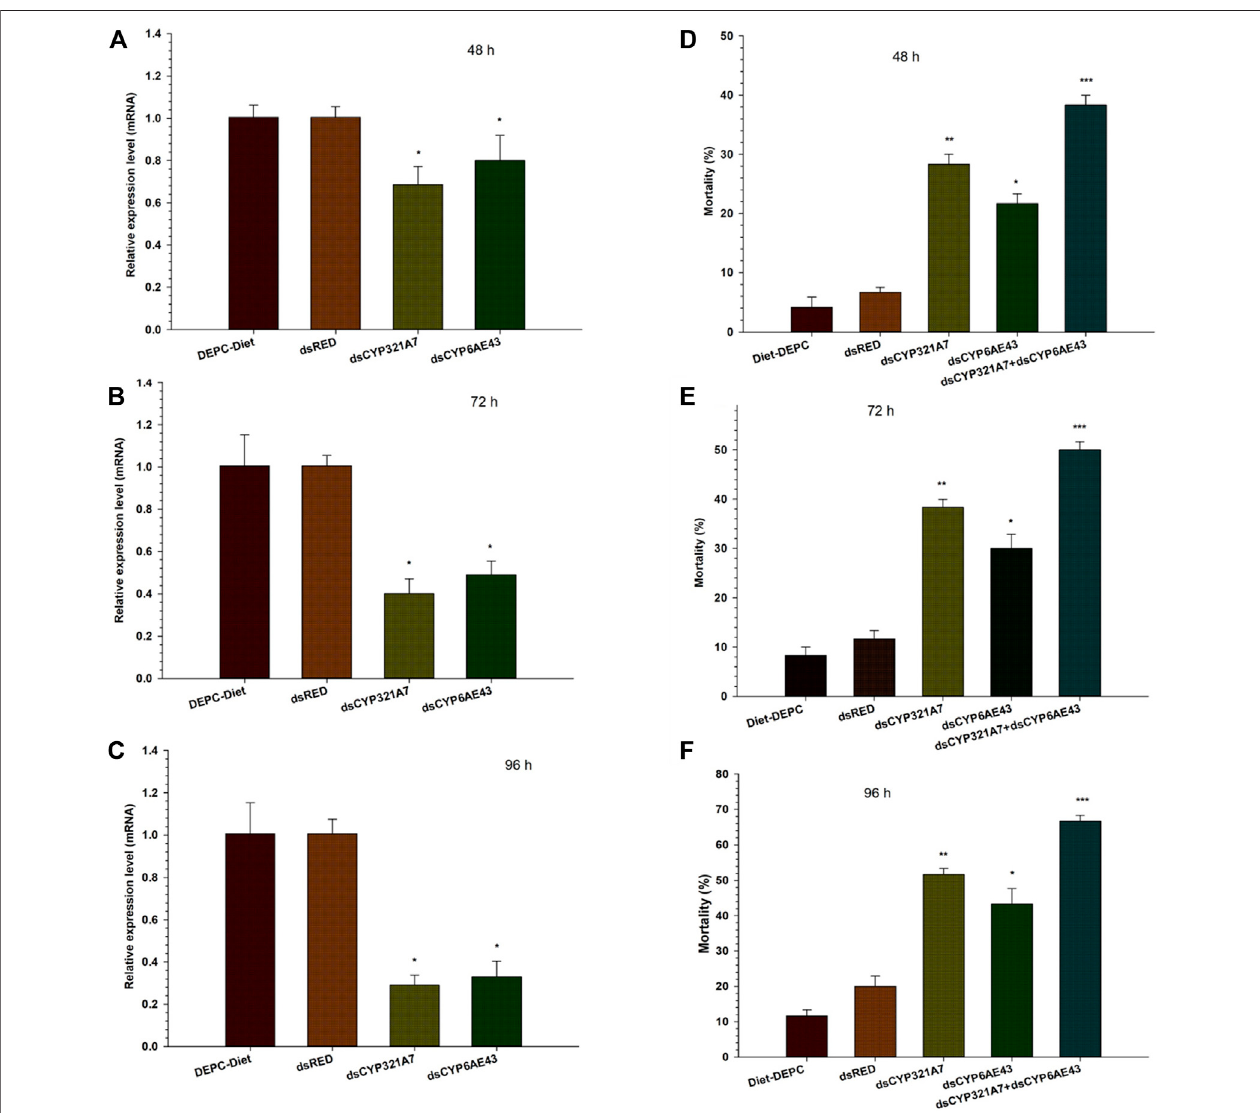
FIGURE 5 | The relative mRNA transcript levels in the midguts of S. frugiperda larvae (Indox-SEL population) after feeding on dsCYP321A7, dsCYP6AE43 and dsRED for48 h (A) ,72 h (B) and96 h (C) .Similarly,thesingledsCYP321A7,dsCYP6AE43andcombineddsCYP321A7+dsCYP6AE43)ordsREDeffectofdsRNAson the sensibility to indoxacarb in third-instar larvae of S. frugiperda after exposure with LC 20 : 6.84 μ g g − 1 concentration of indoxacarb. After feeding with dsRNAs and dsRED for 24 h followed by the exposed third instar larvae were transferred individually into 12-oriface tissue culture plate containing arti fi cial diets supplemented withLC 20 :6.84 μ g g − 1 ofindoxacarbfor48 h (D) ,72and96 h (F) .DEPC-Dietasacontrol(Indox-UNSELpopulation)withoutexposuretoindoxacarb.Themortalitydata wererecordedat48,72and 96 h.Datashownaremeans±SEderivedfromthreebiologicalreplicates. Theastriksonthebar represent signi fi cantdifferences( p < 0.05) using one-way ANOVA, followed by Tukey ’ s HSD multiple comparison